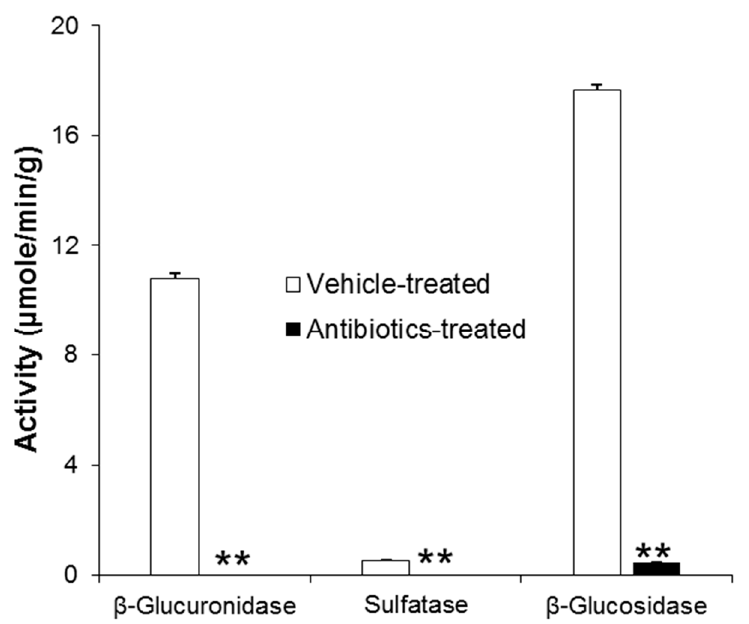
Figure 3. Intestinal microbiota enzyme activities. Asterisks (**) indicate the value significantly different from corresponding controls at p < 0.01.